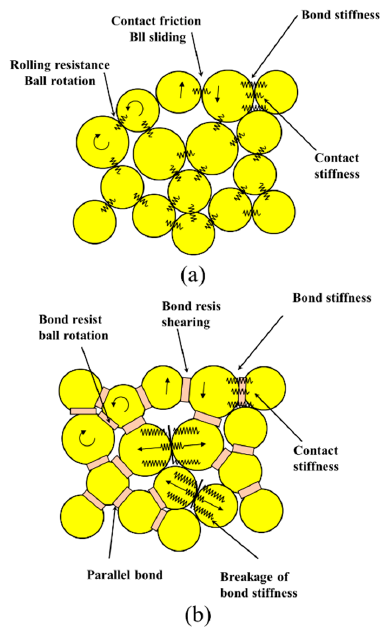
Figure 2. Cohesive model and its micromechanical behavior schematic diagram: ( a ) parallel bond model; ( b ) rolling resistance model [38].